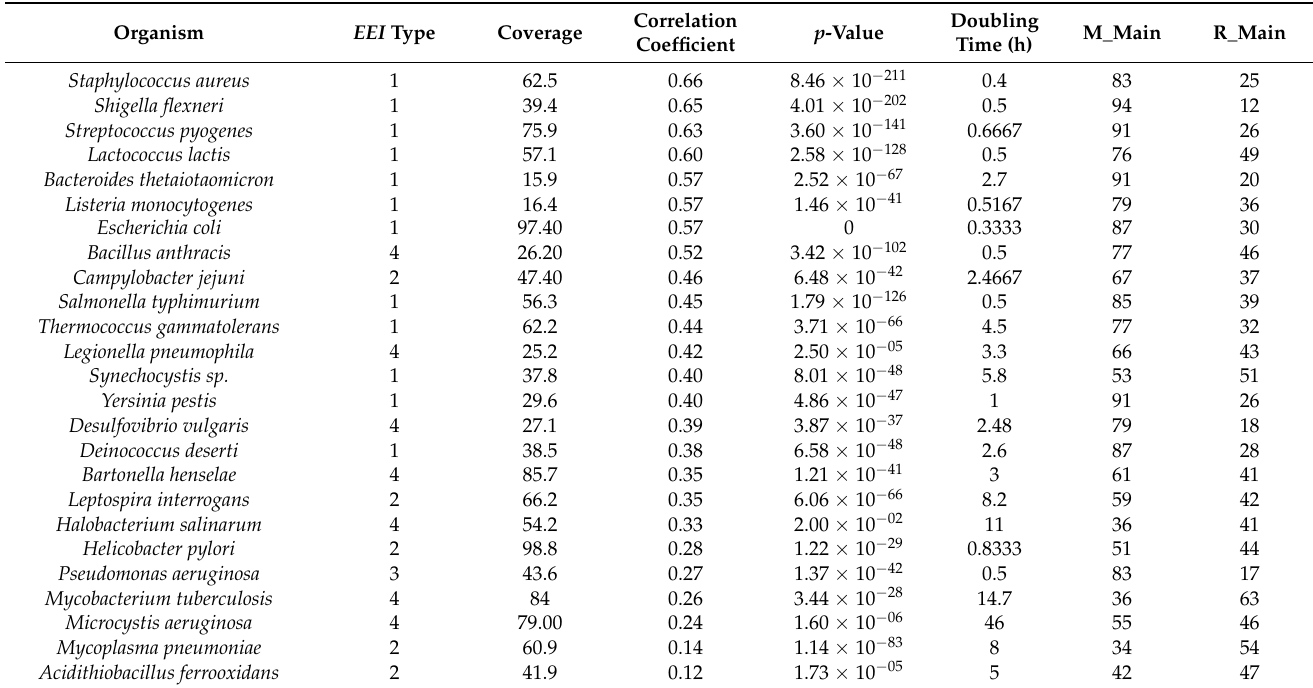
Table 1. Values of the analyzed parameters for the studied organisms: elongation efficiency type ( EEI type), which was obtained by EloE (see the details in Materials and Methods section); coverage of proteomic data; Spearman correlation coefficients between protein abundance and base EEI index; corresponding p -value; minimal doubling time (see the references in Table 4); mean (M) and standard deviation (R) values of ranks of ribosomal protein genes measured on the base EEI scale. Doubling Correlation p -Value Organism EEI Type Coverage Time Coefficient